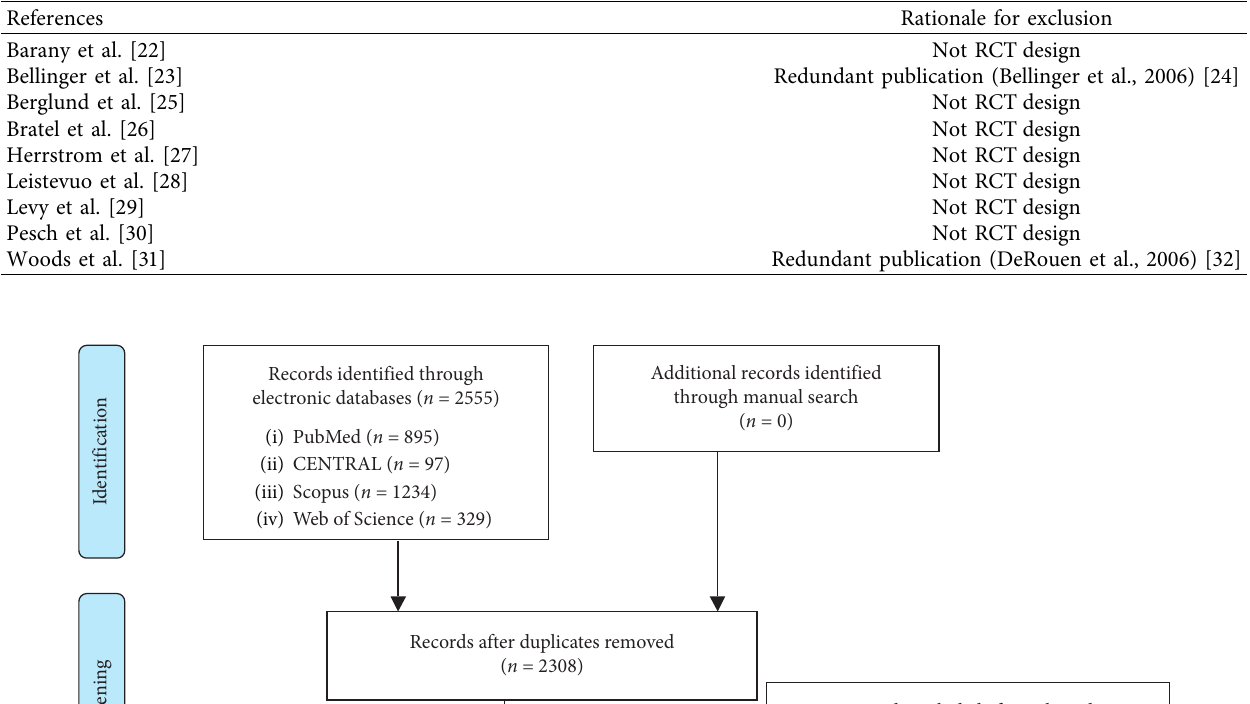
Table 1: Table showing references of excluded studies after full-text evaluation with rationale for exclusion.